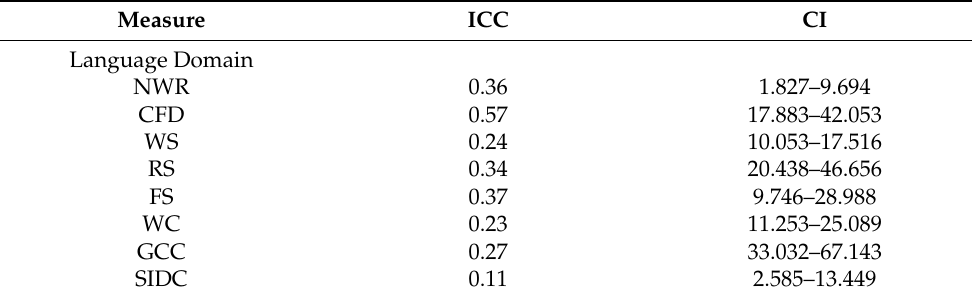
Table 4. Intra-class correlation and confidence intervals (CI) for Language Measures and CCC-2 Composites.